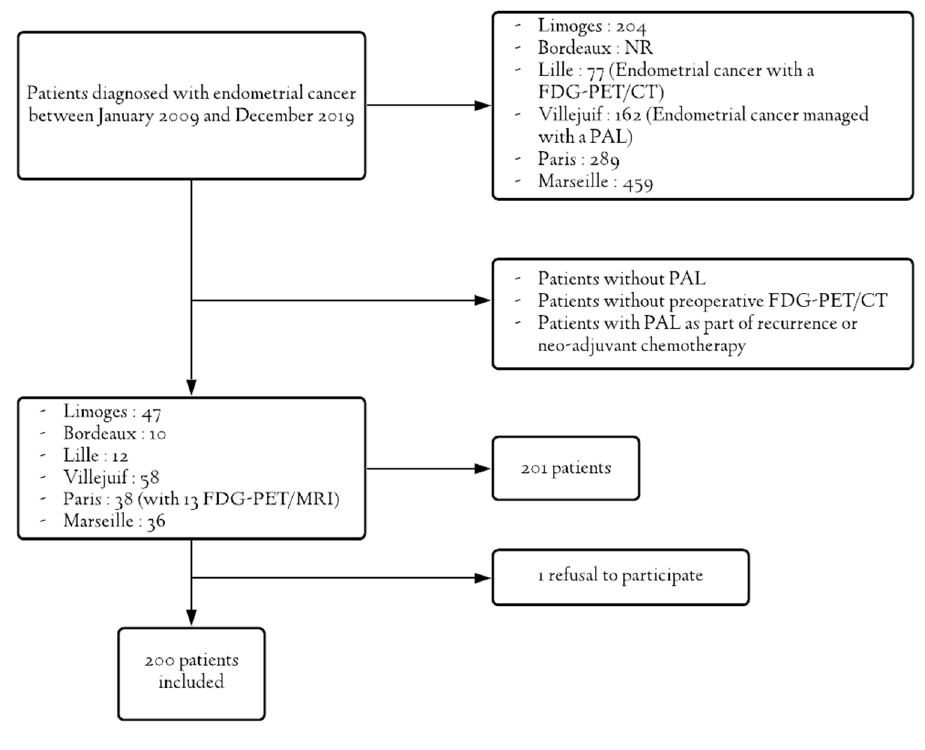
Figure 1. Figure 1. Flowchart.